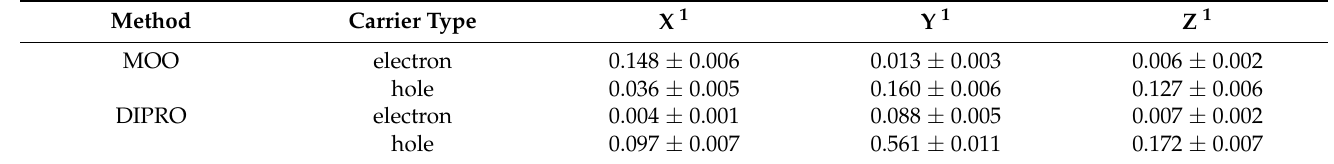
Figure 3. Distribution of transfer integrals in crystalline porphine: ( a , b ) DIPRO method; ( c , d ) MOO method. Table 2. Charge mobility in cm 2 /V·s with standard deviation, obtained by the KMC method (aver- aged over 10 launches), superimposed field 10 6